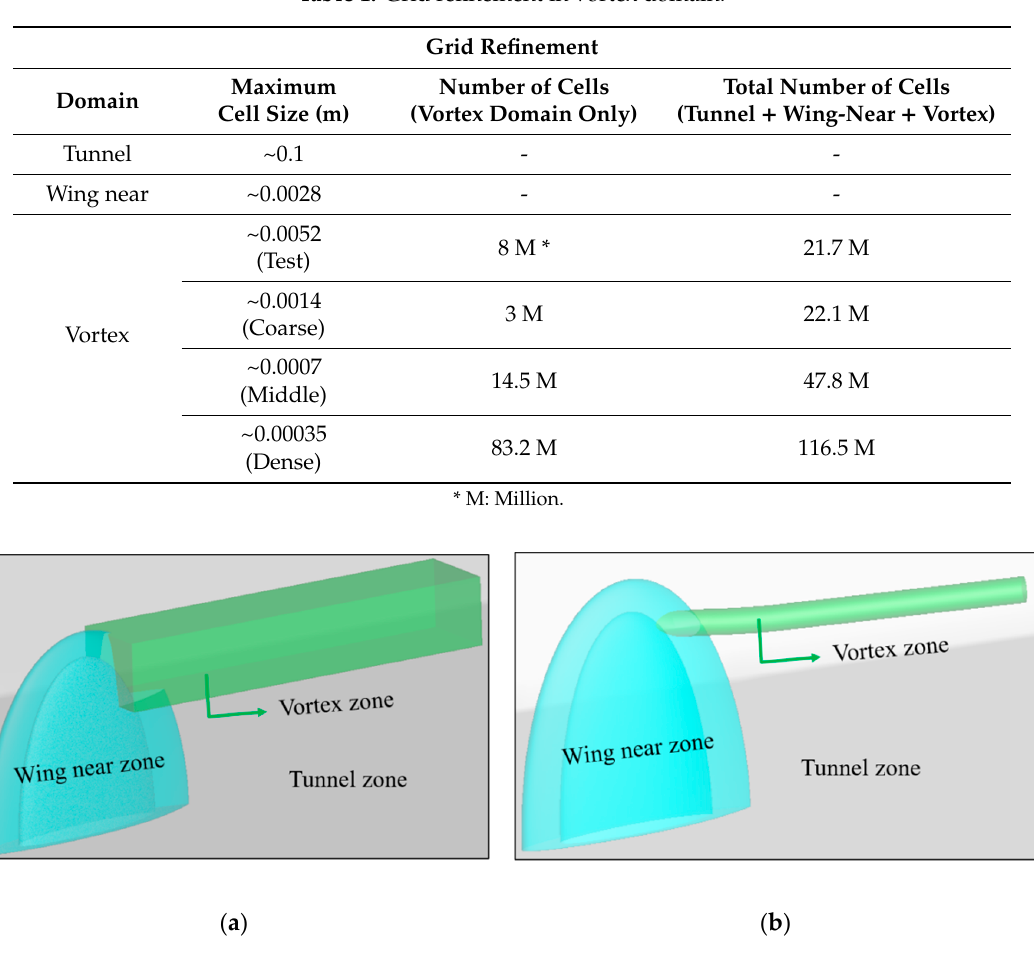
Figure 3. Magnifiedcomputationaldomainsfor( a )testgridsand( b Figure 3. Magnified computational domains for ( a ) test grids and ( b ) coarse, middle, and dense grids domain.